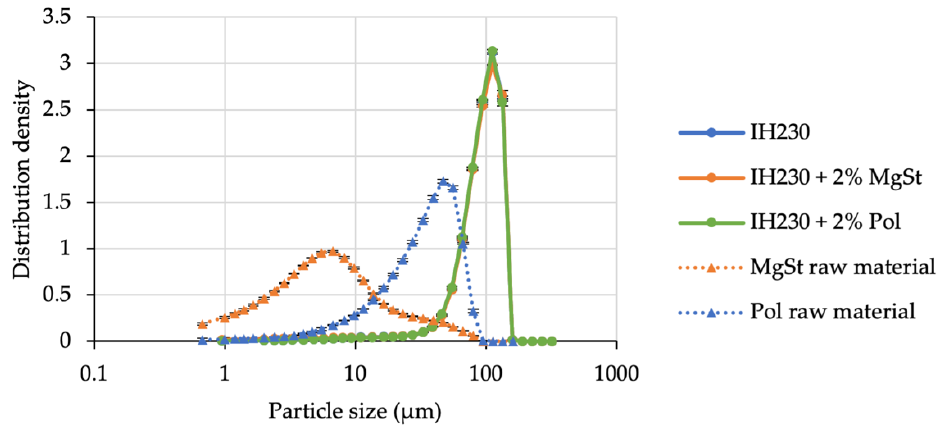
Figure 1. Particle size distribution of the carrier lactose with and without additives. n = 3, error bars denote standard deviation.